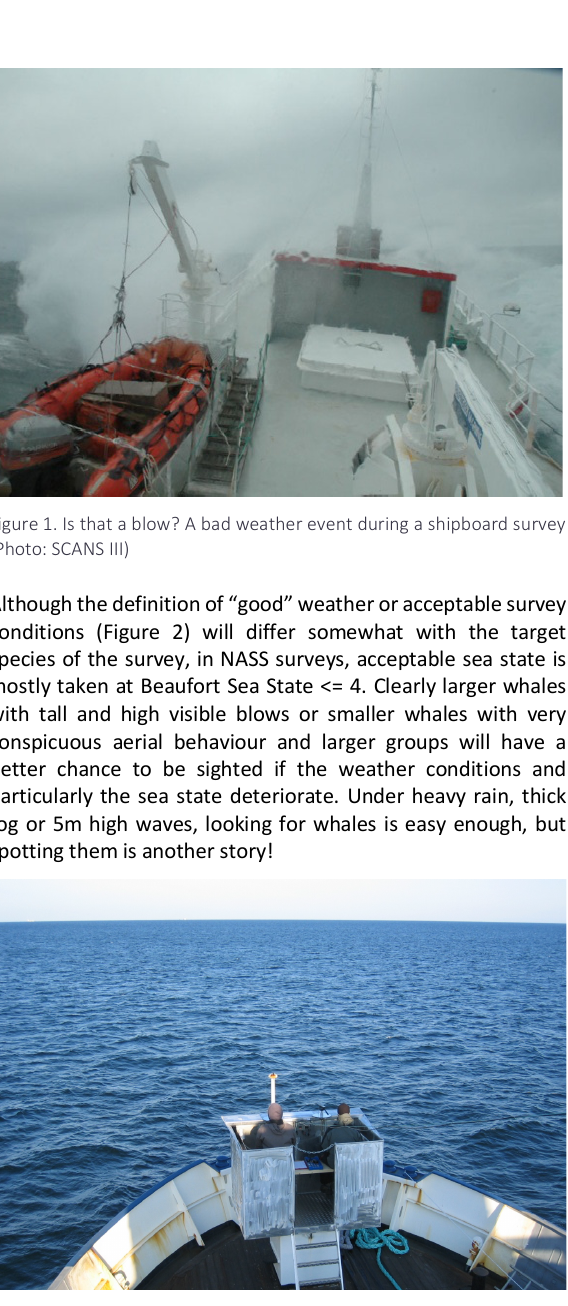
Figure 2. Acceptable sighting conditions (Photo: SCANS